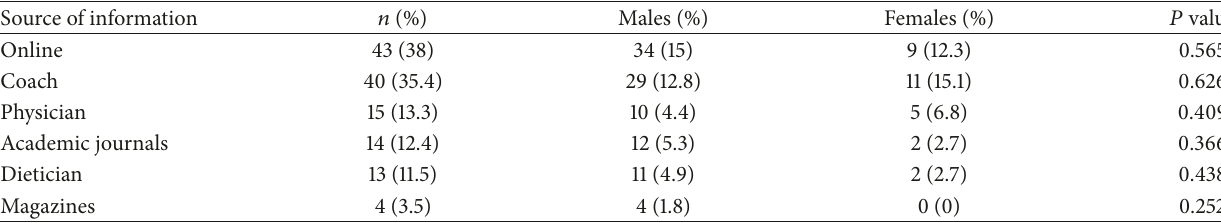
Table 2: Source of information.